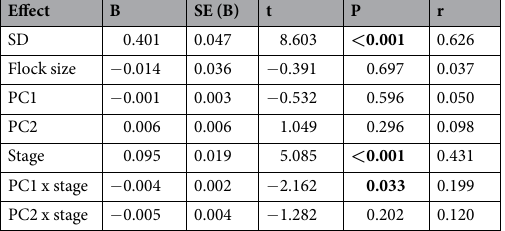
FID and season and species traits.